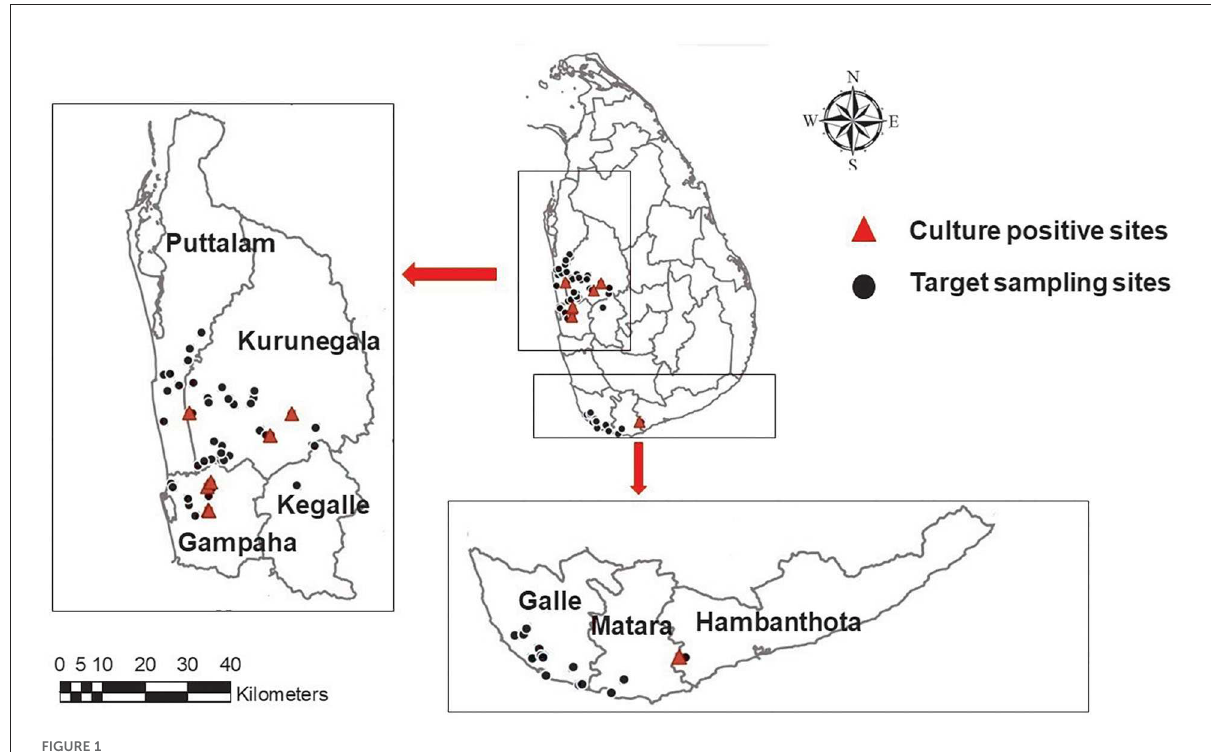
FIGURE1 A map showing the geographical distribution of targeted sampling sites in western, northwestern, and southern parts of Sri Lanka; ( )-target sampling sites, ( ) culture positive sites. Maps of the study region were generated using ArcGIS software version